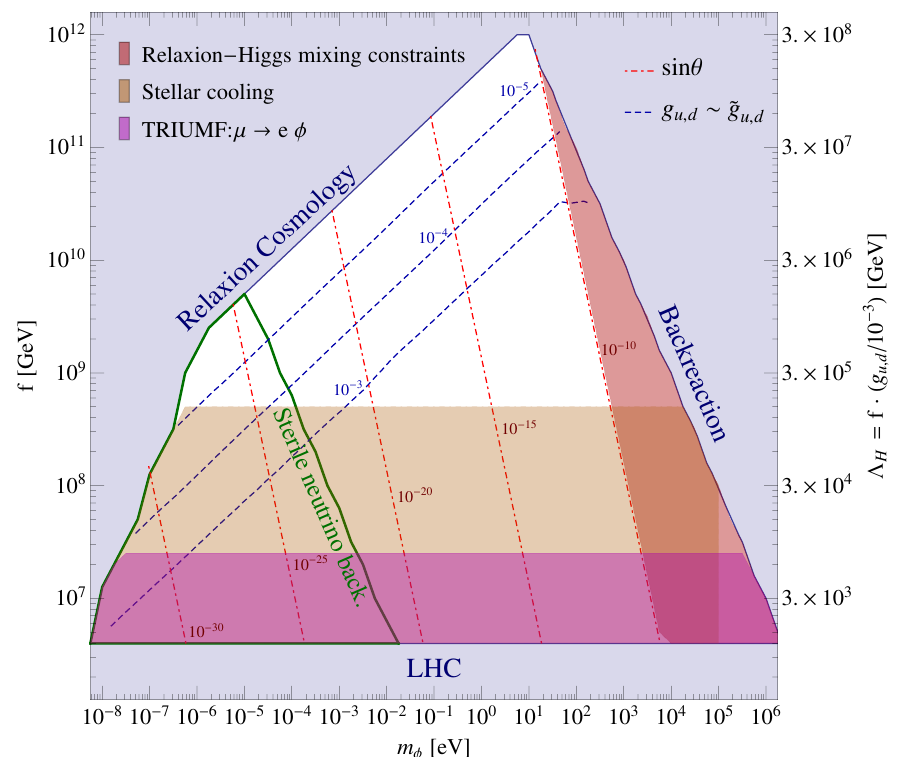
Figure 2 . Allowed parameter space of the hierarchion construction. We marginalize on g u;d ~ g u;d (10 (cid:0) 3 ; 10 (cid:0) 6 ). The blue dashed contours indicate the maximal value of these couplings. 2 The blue shaded boundaries results from LHC constraints, having successful relaxion cosmology (see eq. (5.1)), and the upper bound on the backreaction scale in eq. (2.5). In the region inside the green boundary, the backreaction is generated by the sterile neutrino portal (see eq. (4.11)). We include constraints on the hierarchion from its Higgs portal couplings [41] (red), from (cid:13)avor violating muon decays [32] (magenta), and star cooling from electron coupling [70, 71] (orange). The red dot-dashed contours correspond to the relaxion-Higgs mixing in eq. (5.4).